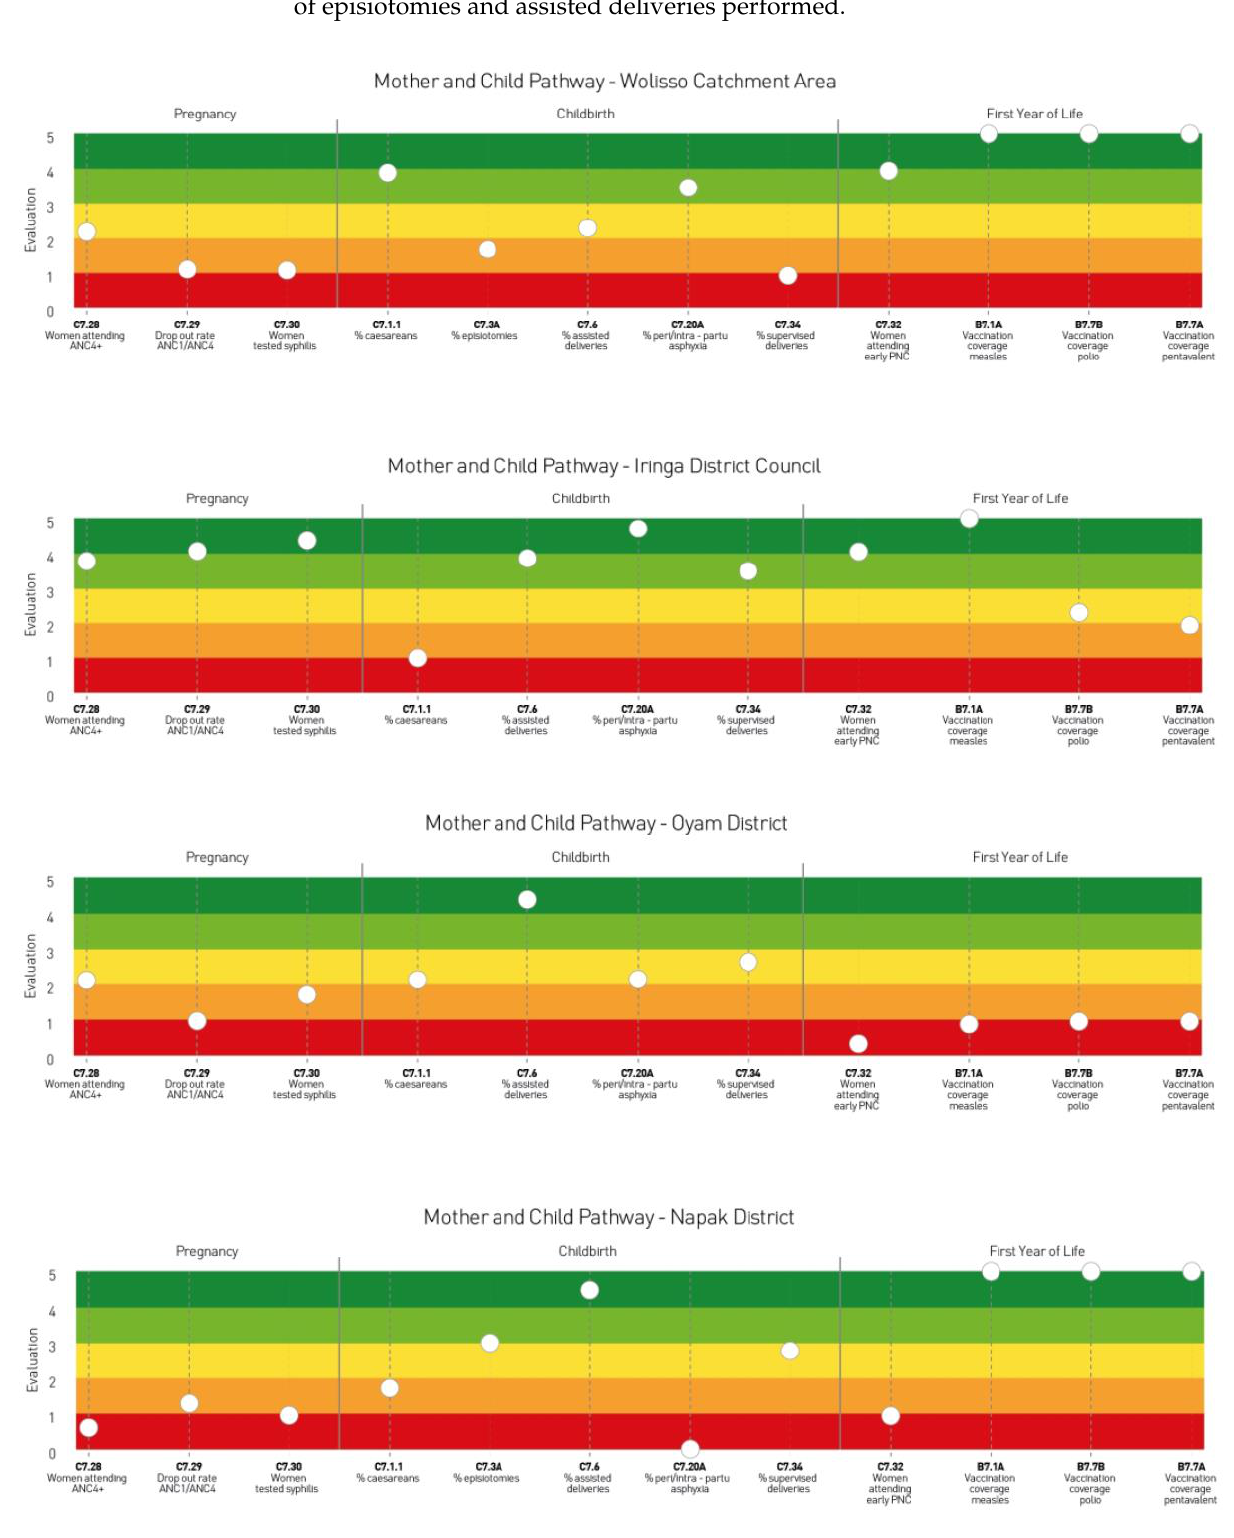
Figure 3. Example of staves related to the performance of the Maternal and Childcare pathway of Iringa District Council (Tanzania), Napak and Oyam Districts (Uganda) and Wolisso Catchment Area (Ethiopia).